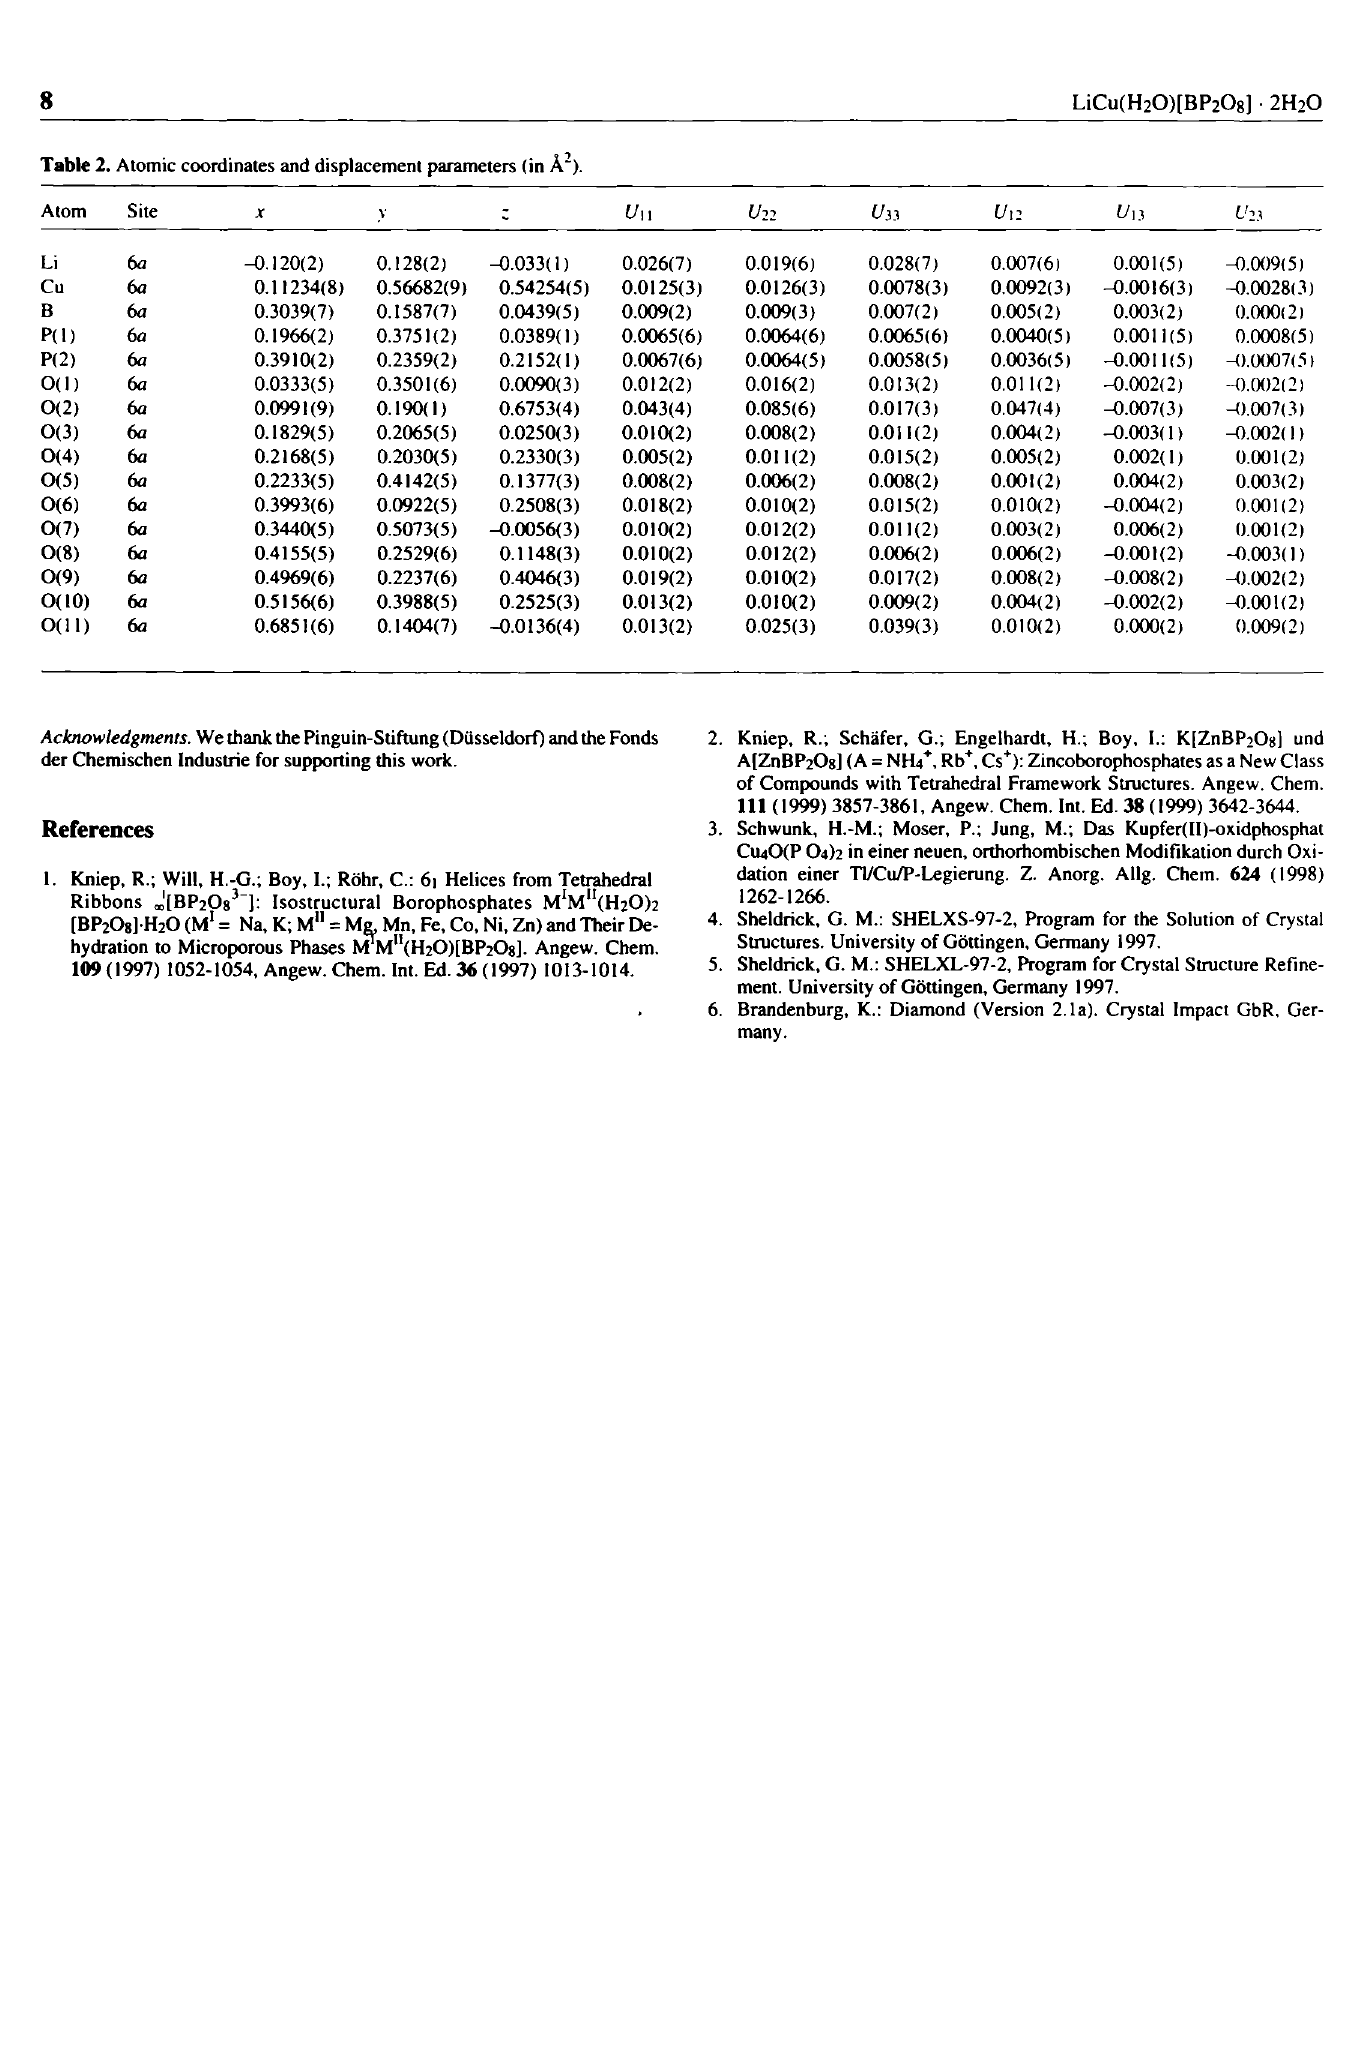
Table 2. Atomic coordinates and displacement parameters (in Ä 2